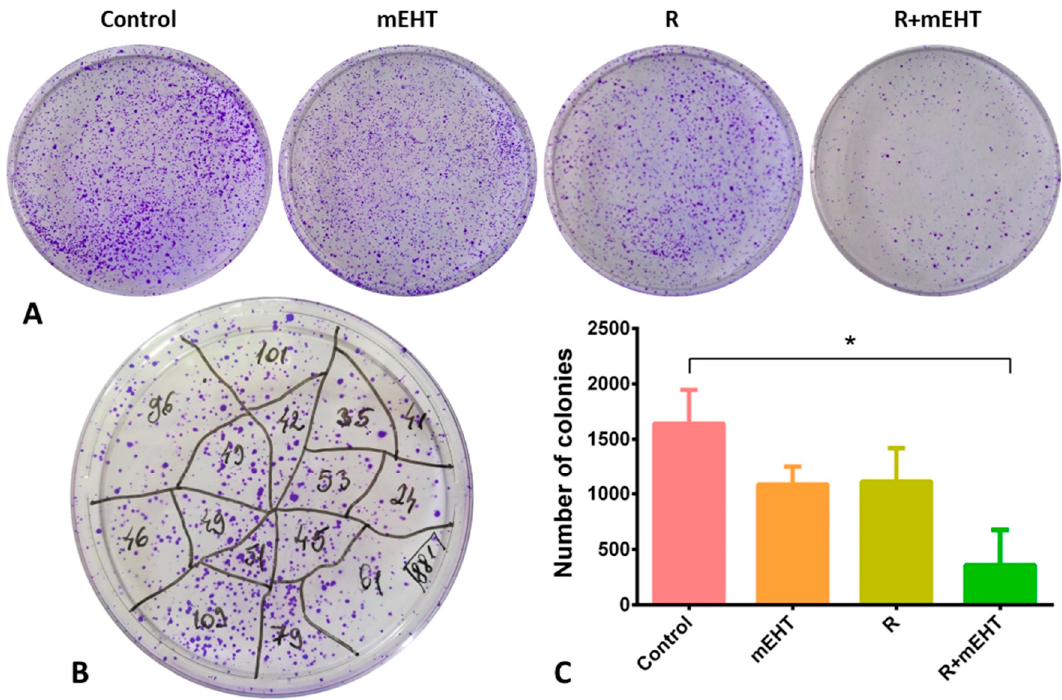
Figure 3. Clonogenic assay after different treatments of Panc1 tumor cells. Representative images of formalin-fixed, crystal violet stained colonies 8 days after treatment ( A ). Reliable counting of the colonies was based on dividing the plate areas into segments ( B ). Statistical analysis revealed a significant reduction after R+mEHT treatment compared to the control group ( p = 0.0195) ( C ). Kruskal – Wallis test also showed a significant difference among the 4 groups ( p = 0.0064) TER = 3.1. The asterisk (*) marks the value of p ≤ 0.05.